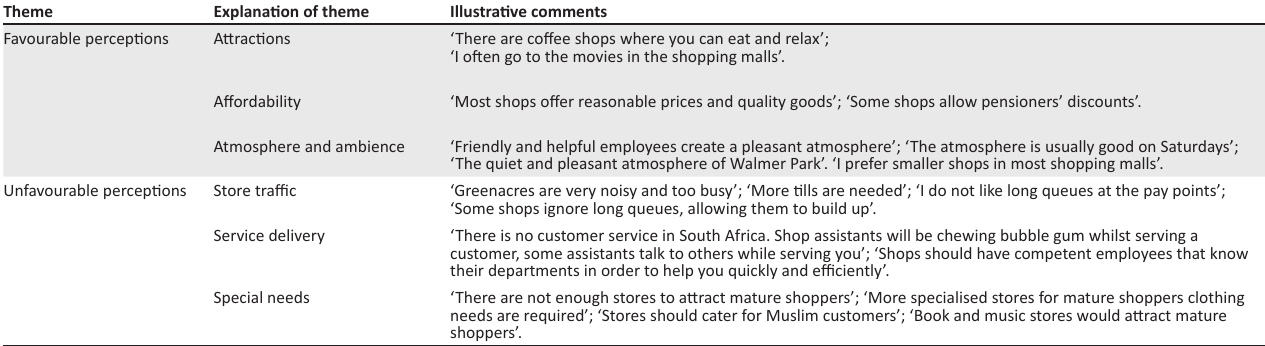
TABLE 2: Focus group participants’ favourable and unfavourable perceptions of shopping